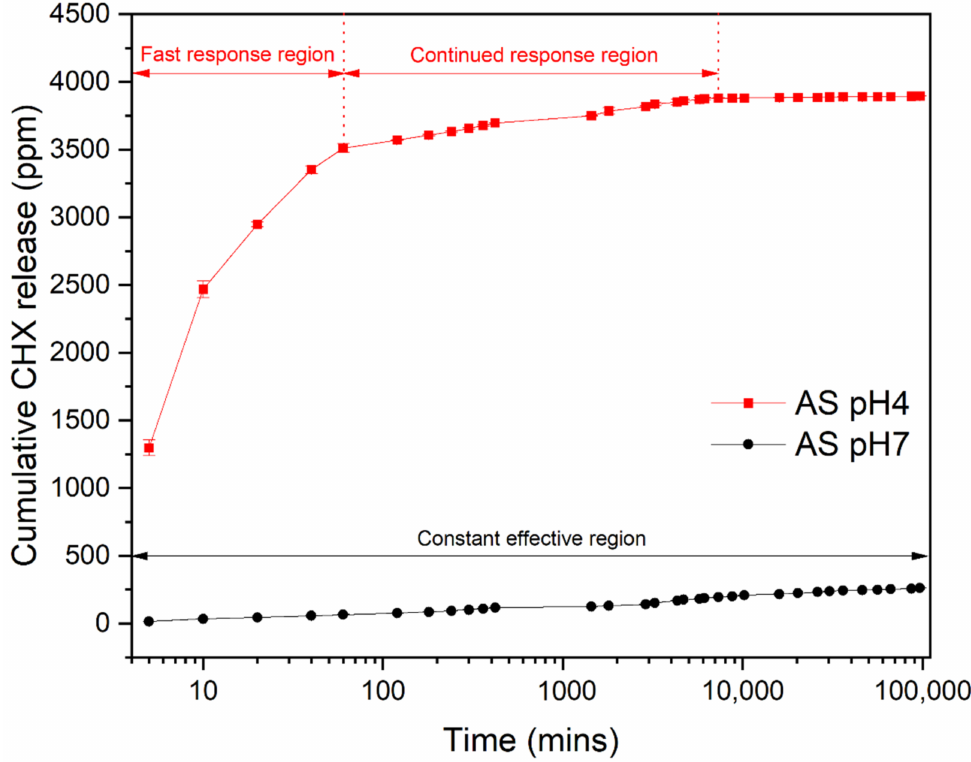
Figure 8. Cumulative zinc release from CHX-ZnCl 2 particles in artificial saliva (pH = 4 or pH =